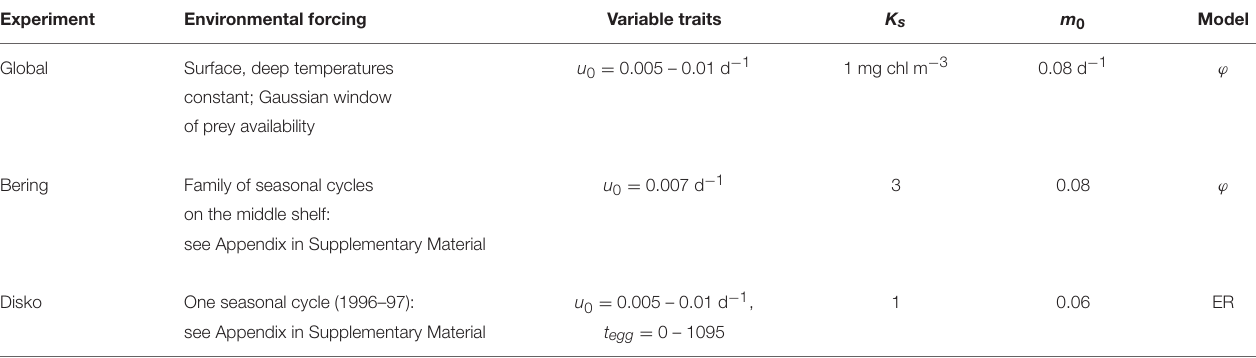
TABLE 2 | Setup of model